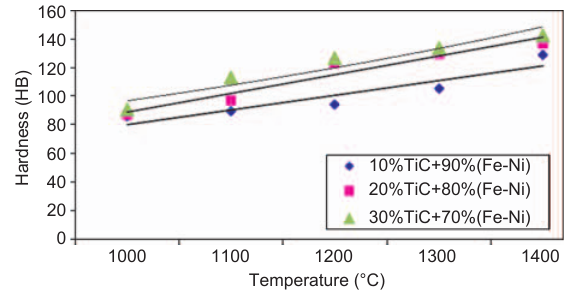
Figure 4 Hardness against sintering temperature.